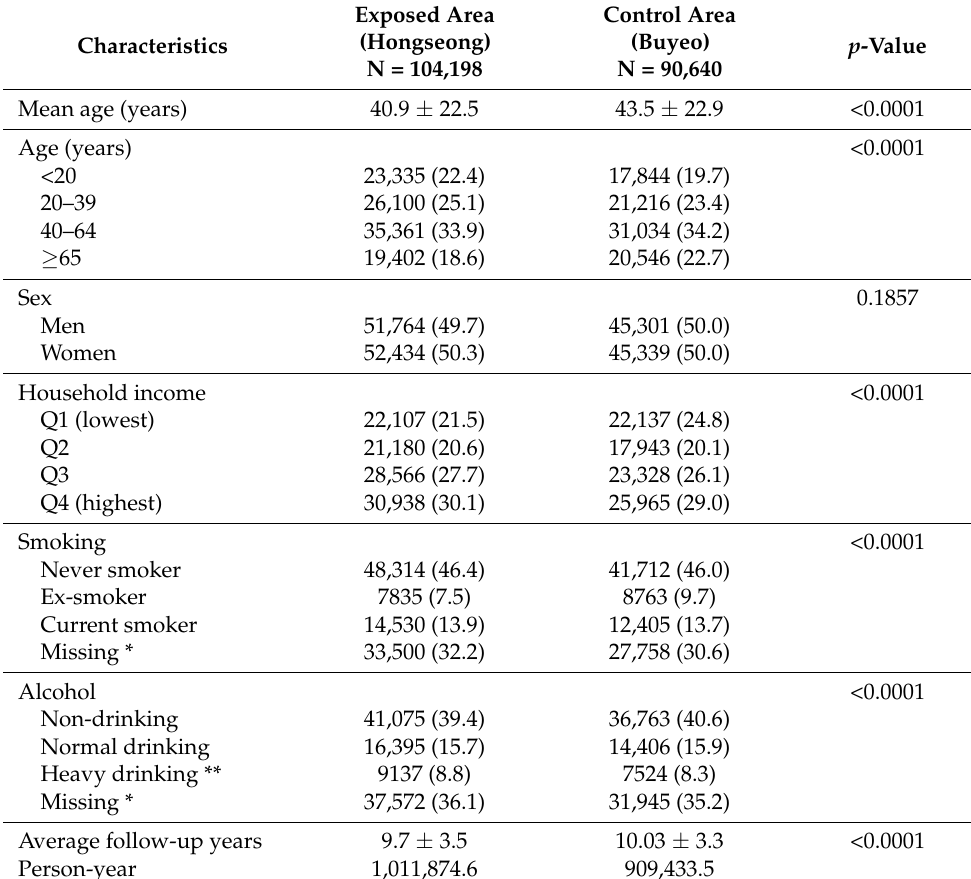
Table 1. Baseline characteristics of the